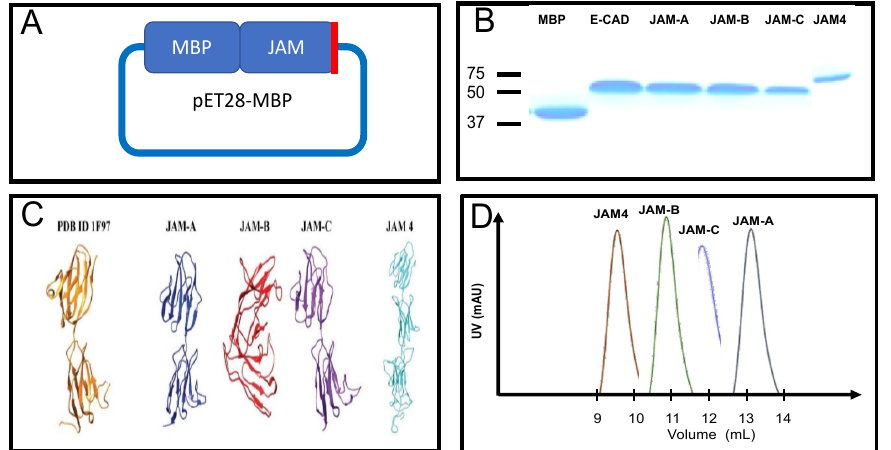
Figure 1. Characterization of junction adhesion molecule (JAM) family of proteins. ( A ) Extracellular domains of human epithelial cadherin (E-CAD) or JAM proteins (Supplemental Information, Figure S3) were cloned C-terminal to maltose binding protein (MBP) in pET28a backbone plasmid, the red line indicates a 6xHIS tag C-terminal to the target protein. ( B ) Proteins are purified with amylose resin and size exclusion chromatography. Proteins are purified to >95% purity, Coomassie blue stain gel. ( C ) Additional characterization was performed through in silico protein models (see Materials and Methods) of JAMs, the crystal structure of JAM-A (PDB ID: 1F97) is next to the models for comparison. ( D ) Size exclusion profiles are overlapped to show how each JAM protein forms unique quaternary structures.